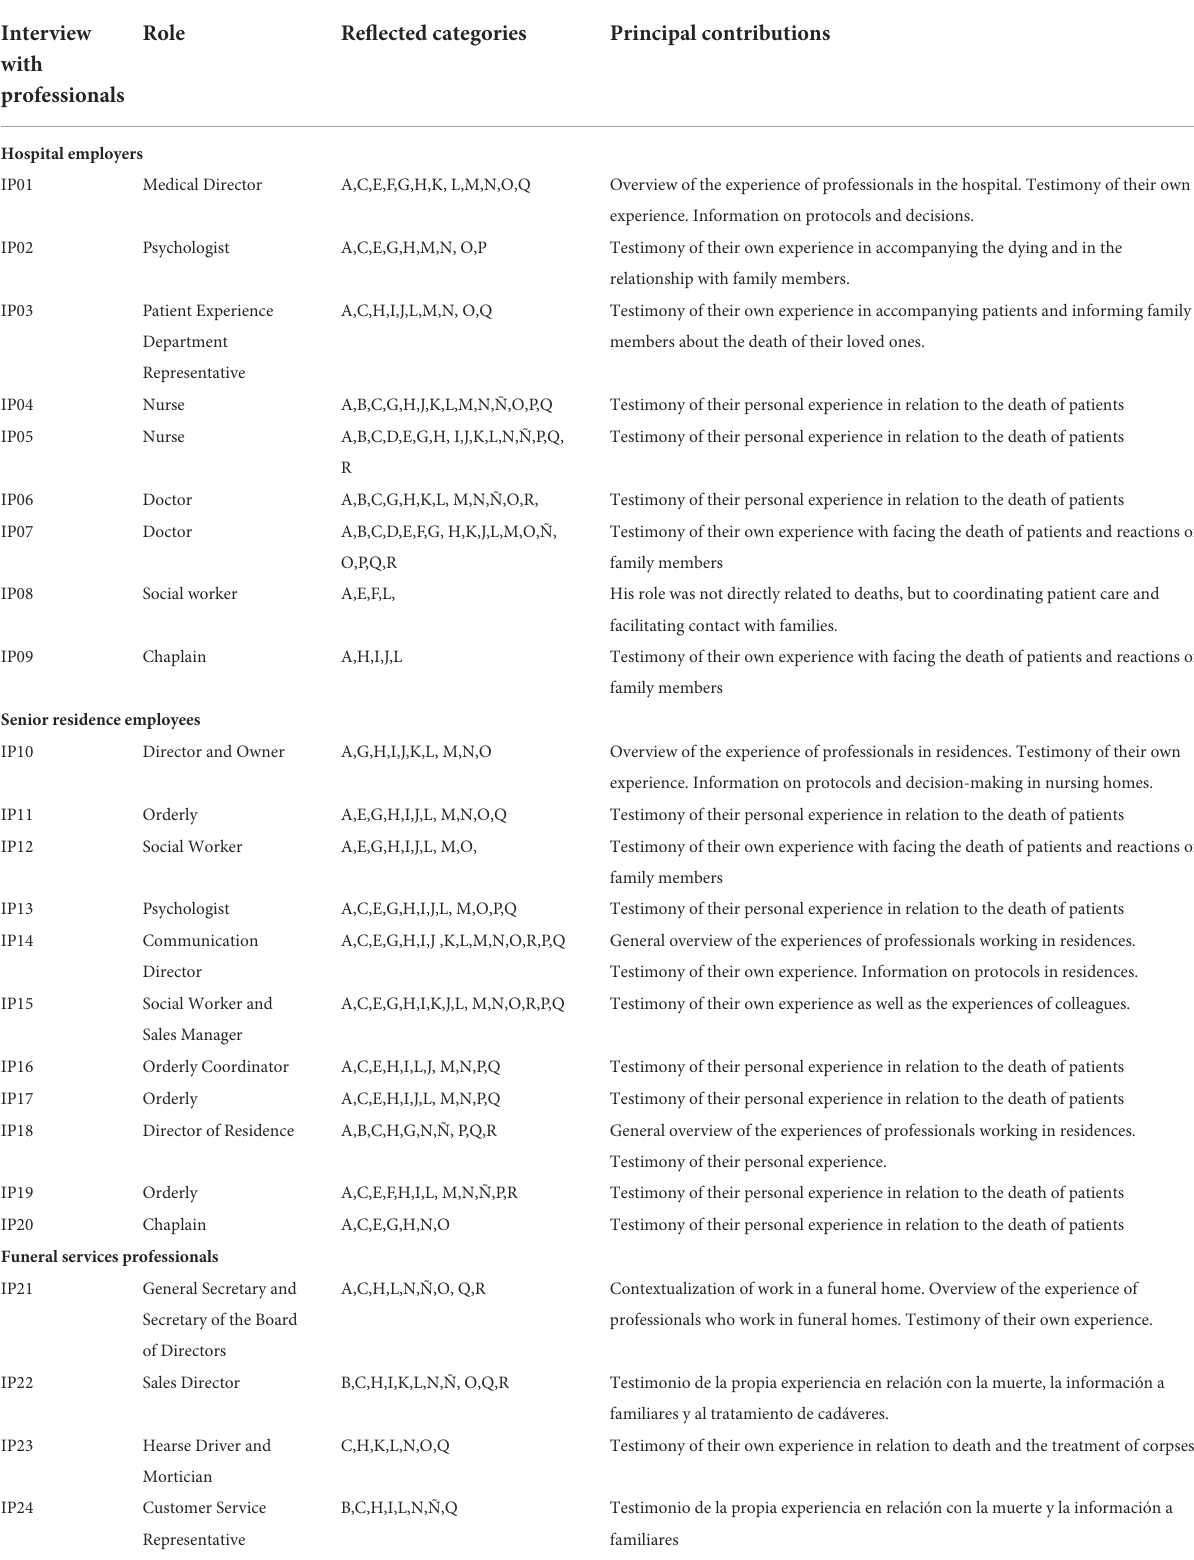
TABLE 1 Data sheet of the subjects interviewed and